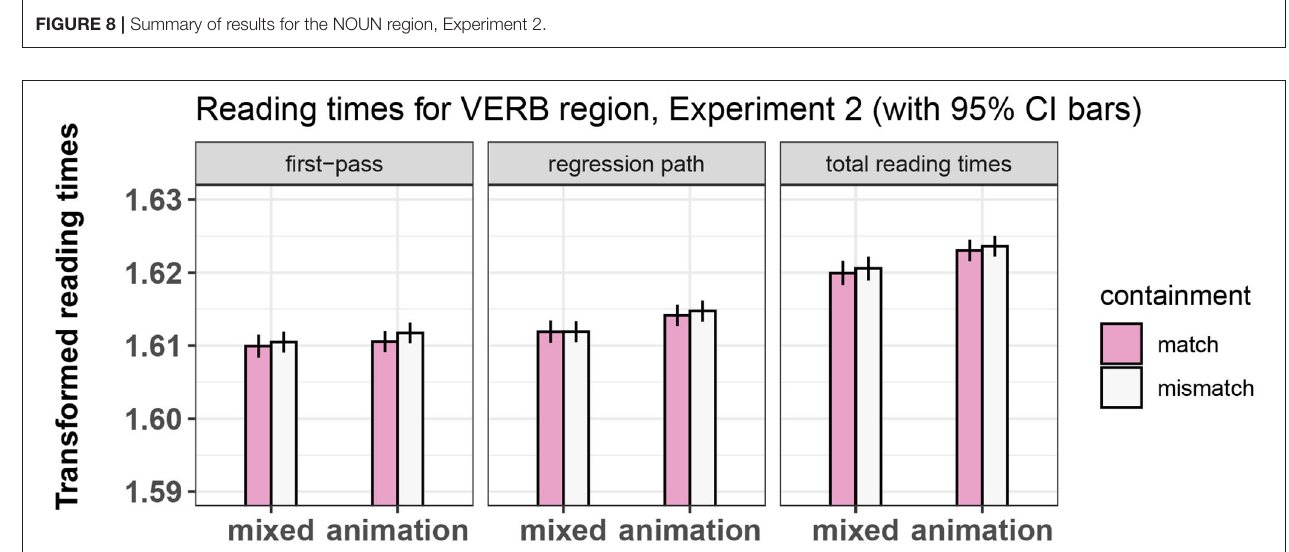
Frontiers in Psychology |